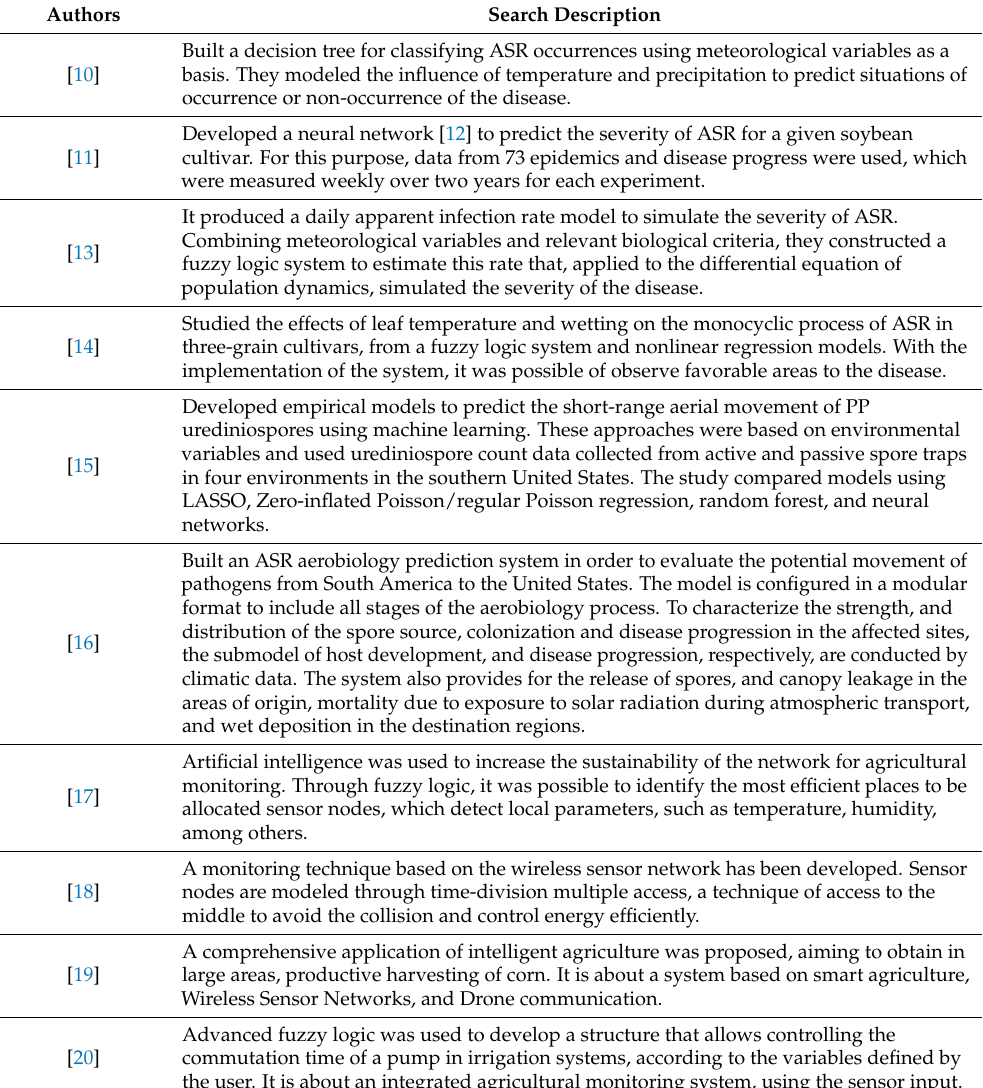
Table 1. Main related